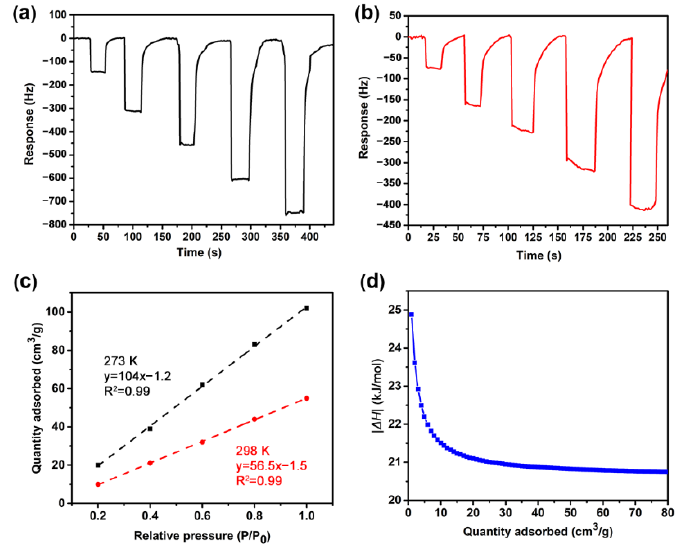
Figure 4. CO 2 absorption curves of the UiO-66 QCM sensor: ( a ) 273 and ( b ) 298 K. The CO 2 adsorption ( c ) isotherm and ( d ) enthalpy curve of the UiO-66.